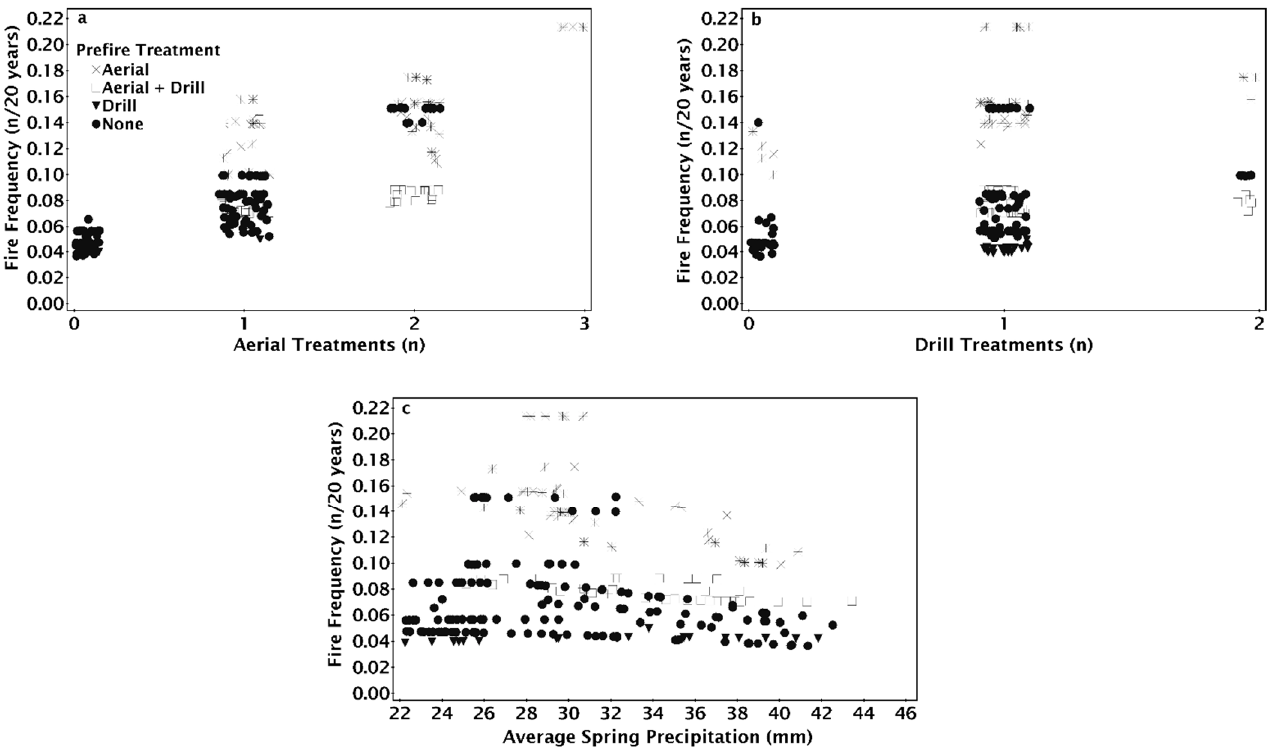
Figure 8. The modeled relationship between fire frequency grouped by the type of pre-fire seeding. jittering along the x-axis ( a,b ) or y-axis ( c ) was used to see overlapping treatments.